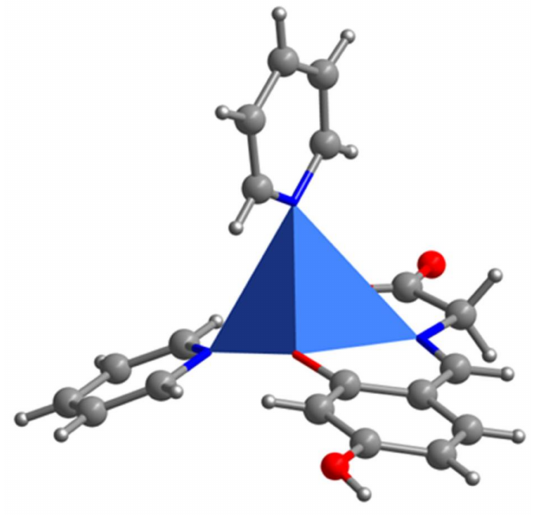
Figure 4. The polyhedron of Complex 2 .